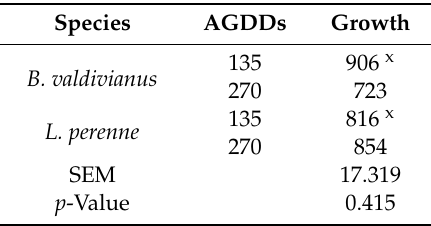
Table 2. Mean growth (kg DM ha − 1 ) of Bromus valdivianus Phil. and Lolium perenne L. defoliated after 135 and 270 accumulated growing degree days